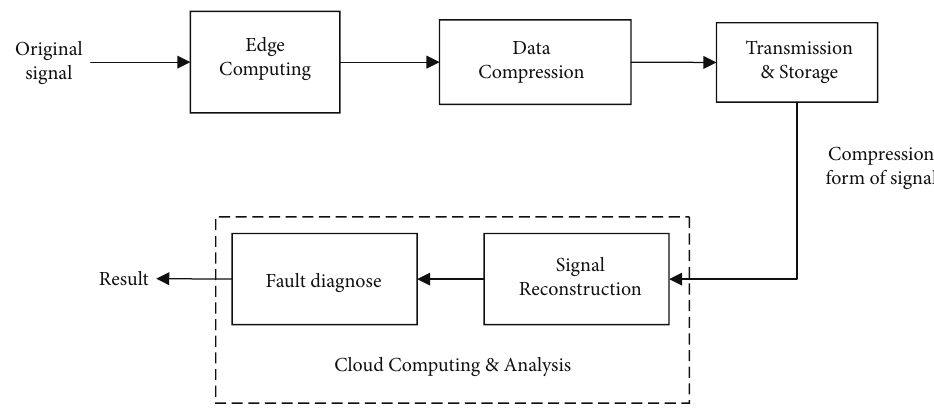
Figure 1: Signal analysis process of equipment